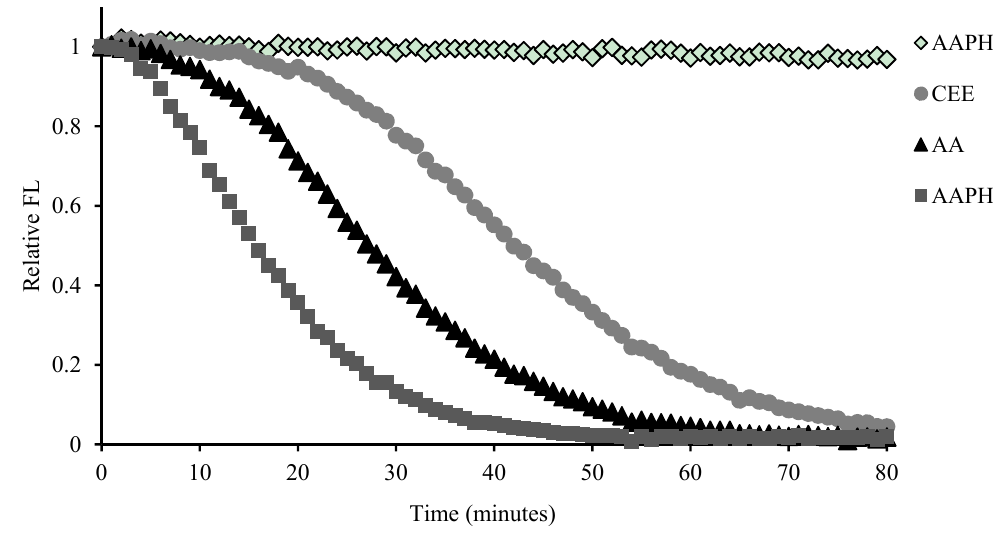
Figure 5. Fluorescence (FL) decay curve during oxygen radical absorbance capacity (ORAC) assay in the presence of CEE (60% ethanol eluate of C. endivia , 2 μ g/mL), and AA (ascorbic acid, 2 μ g/mL). AAPH ( − ): the blank which treated without 2,2 ′ -Azobis (2-methylpropionamidine) dihydrochloride (AAPH) and any other samples; AAPH (+): the blank treated with AAPH and without any other